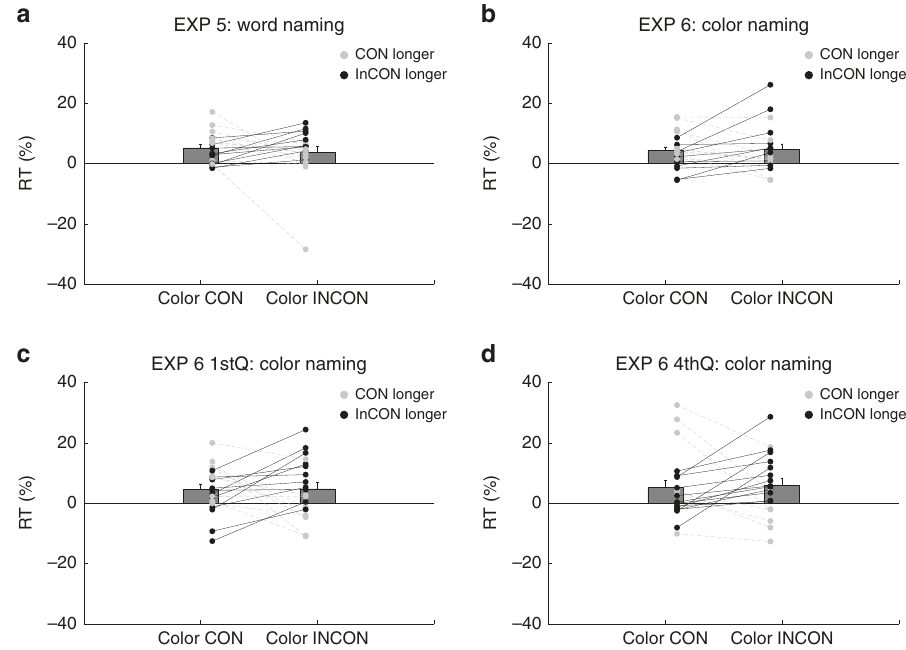
Fig. 4 Experiments 5 and 6 results. n = 20 in each experiment. Y -axis denotes reaction time, and X -axis denotes two critical conditions: color congruent (Color CON) and color incongruent (Color INCON). Each pair of dots represents one participant. Black dots and lines denote longer RT in the color incongruent condition while gray dots and lines denote longer RT in the color congruent condition. The bars denote group mean with the error bars indicating standard error of the mean